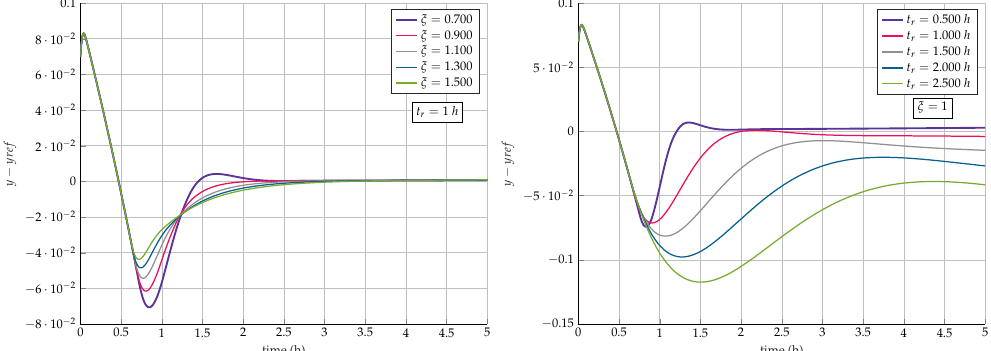
Figure A1. GMC biomass tracking response specification with parameters ξ and t r for the E. coli BL21